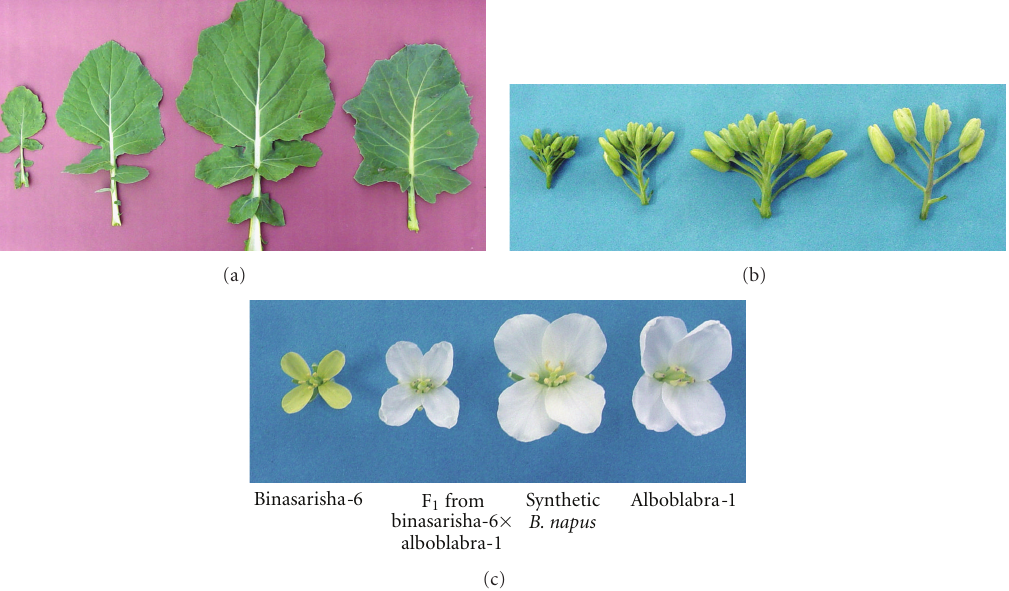
Figure 1: (a) Leaves of Binasarisha-6, F 1 , synthetic B. napus , and Alboglabra-1. (b) Racemes of Binasarisha-6, F 1 hybrid, synthetic B. napus , and Alboglabra-1. (c) Flowers of Binasarisha-6, F 1 hybrid, synthetic B. napus , and Alboglabra-1.